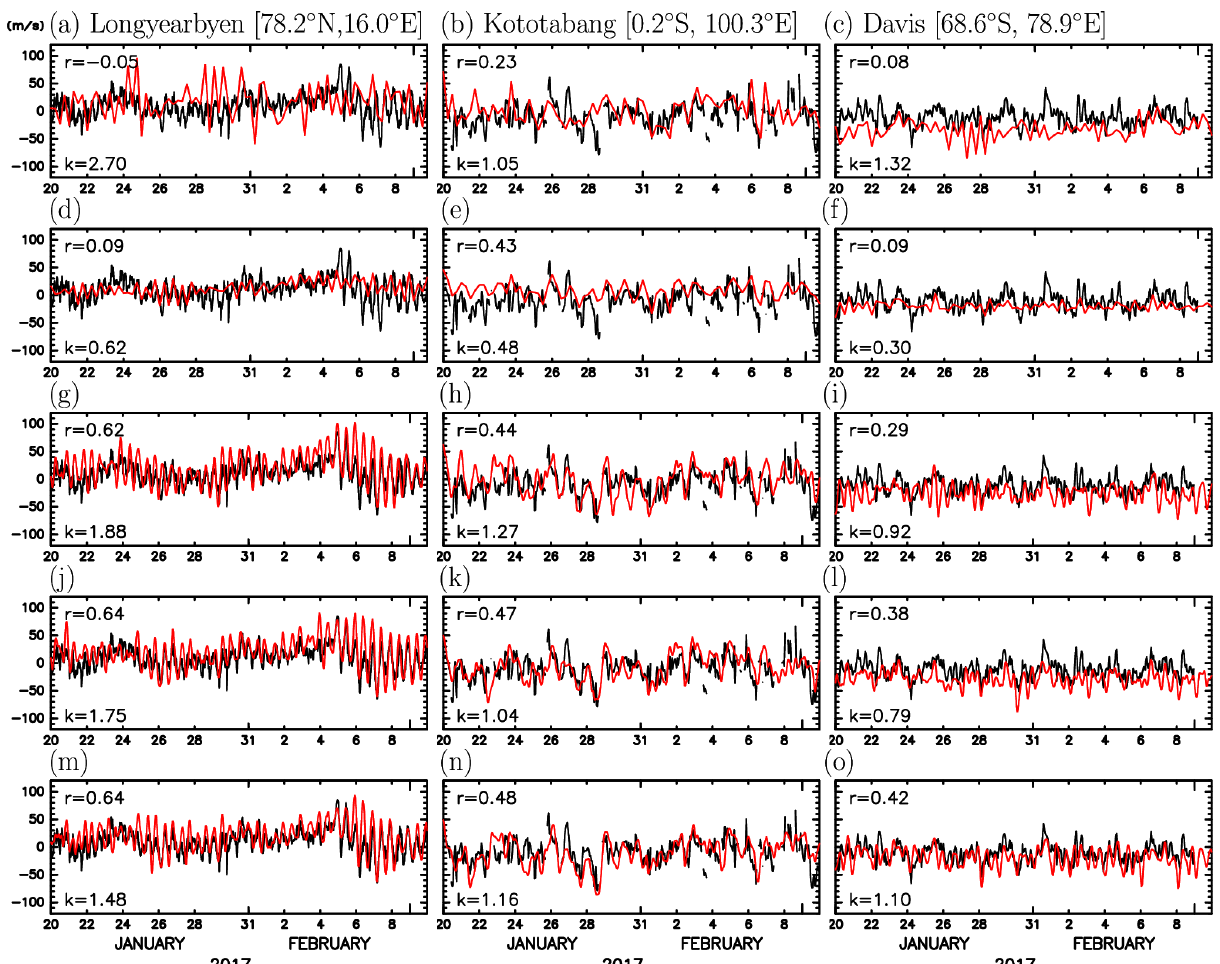
Figure 4. The time series of the zonal wind from analysis (red curves) and observations (black curves) by meteor radars at Longyearbyen in the Arctic (a, d, g, j, m) , Kototabang near the Equator (b, e, h, k, n) , and Davis Station in the Antarctic (c, f, i, l, o) . The results for (top to bottom) the Ctrl (KSMW20) analysis, Expt. I, Expt. II, Expt. III, and Expt. IV (New). Each panel lists the correlation coefficient r and